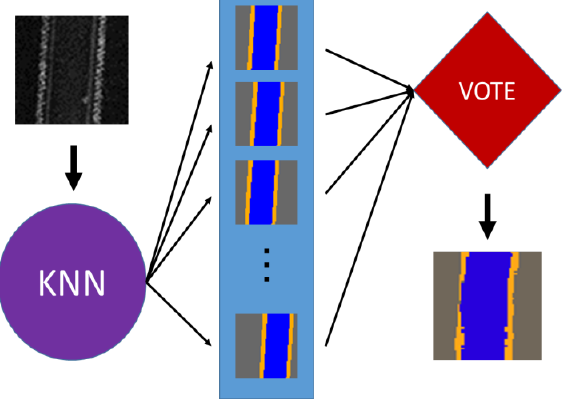
Figure 3. The overview of image labeling by